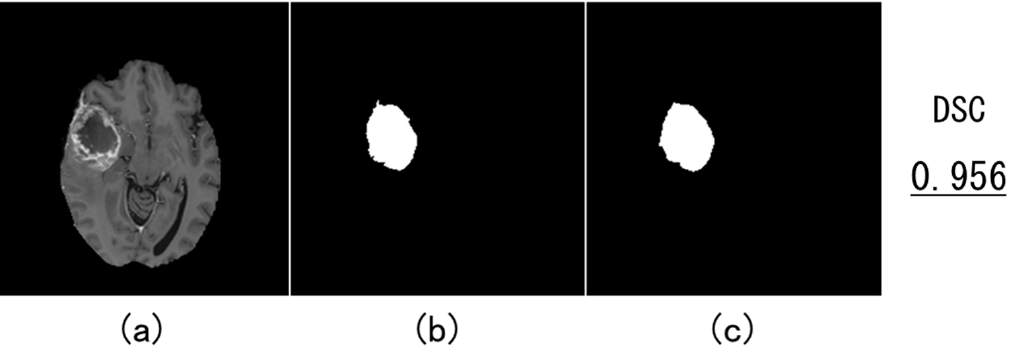
Figure 4. Example of a case with a high similarity index. ( a ) Input image, ( b ) ground-truth image, ( c ) output image, and DSC values calculated in the volume data.